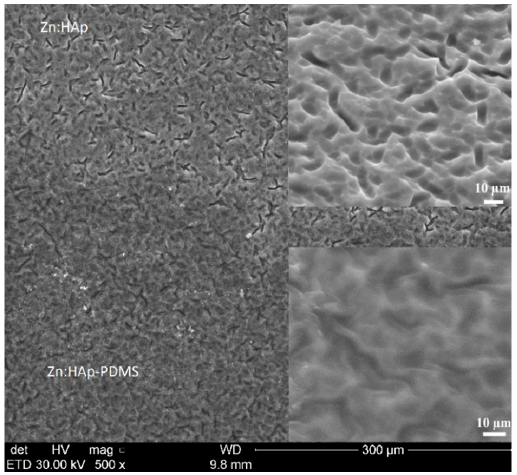
Figure 3. SEM images of the interface zone between Zn:HAp-PDMS and Zn:HAp coating.